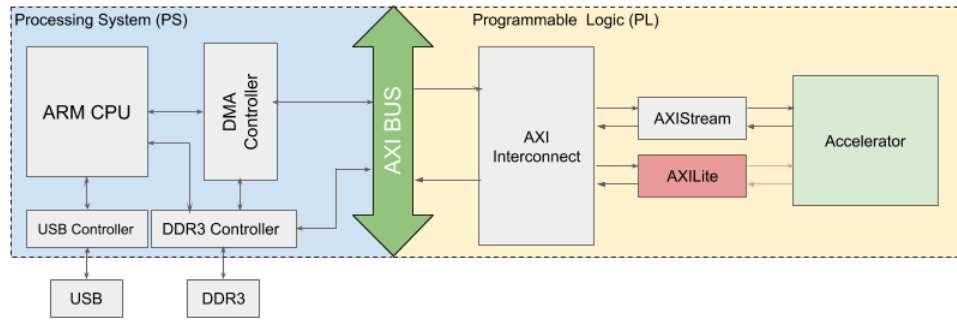
Figure 1. PSoC (Programmable system on chip) and MPSoC (Multi-processor system on chip) simpli- fied hardware architecture diagram. Only the components that have been used in the development of this work are shown. Both heterogeneous PSoC and MPSoC systems have more elements in both PS (Processing System) and PL (Programmable Logic)